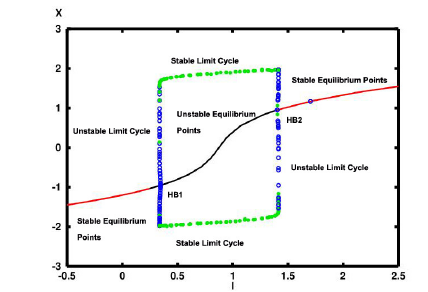
Figure 39. Magnification of figure. Stable (green filled circles) and unstable (blue vacant circles) branches of periodic solution of the BVP model showing di ff erent dynamical be-